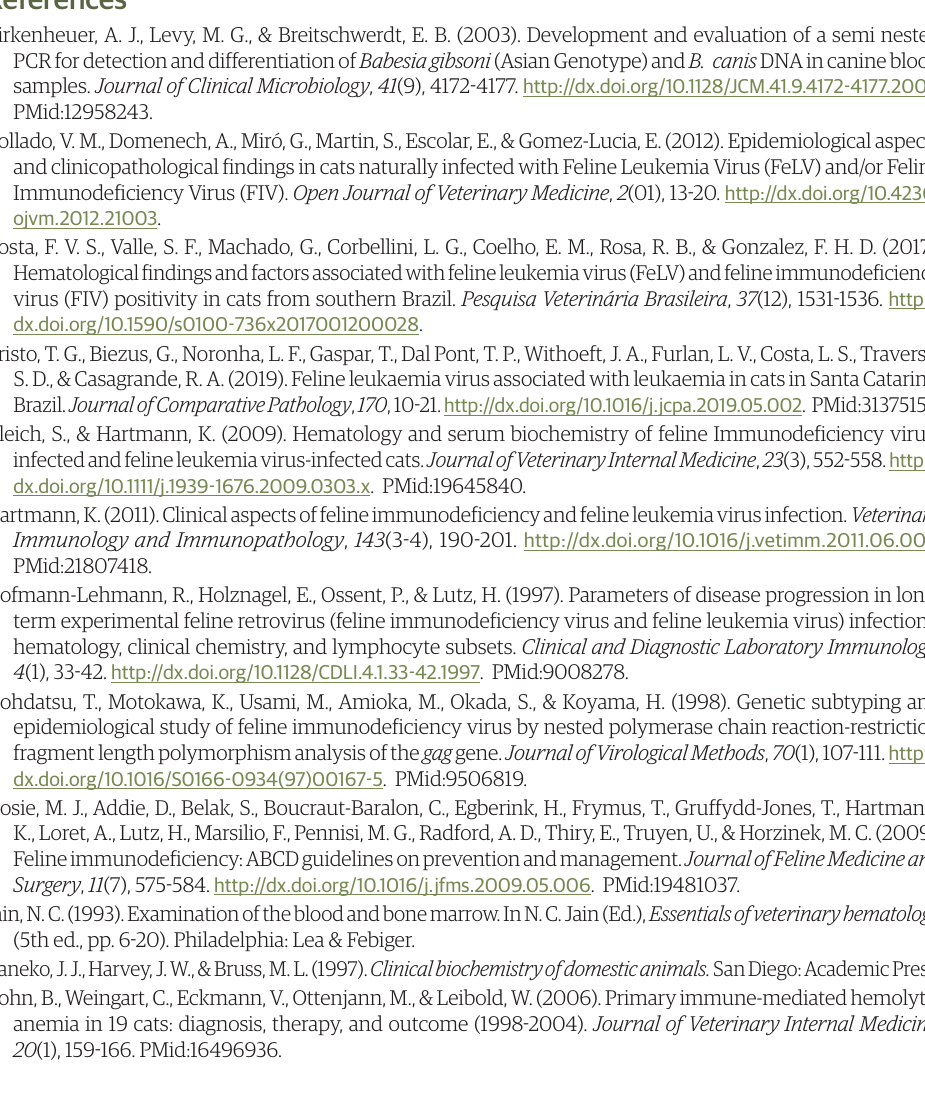
Lacerda et al. 2020. Brazilian Journal of Veterinary Medicine, 42, e110020. DOI: